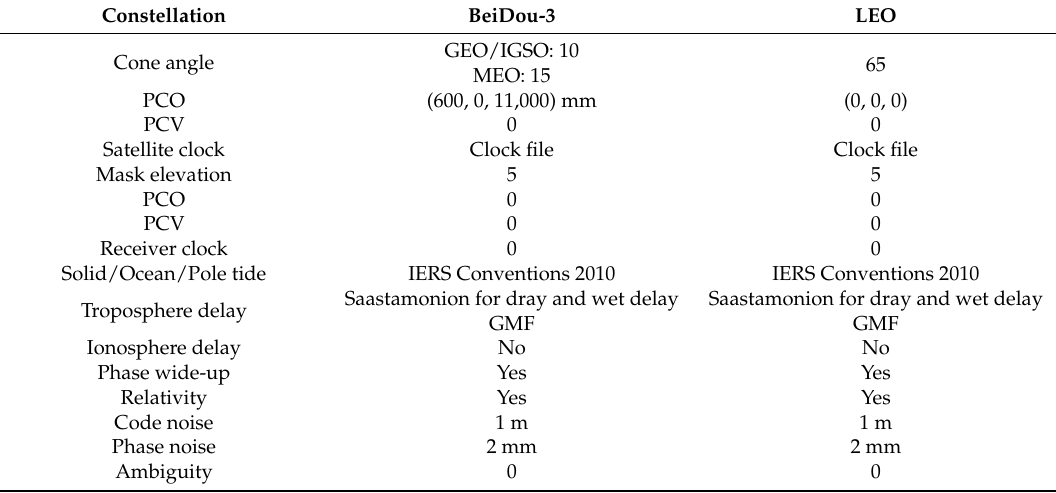
Figure 2. The distribution of selected ground stations ( a ) and ground track of LEO constellation ( b ). Table 4. The configures for observation